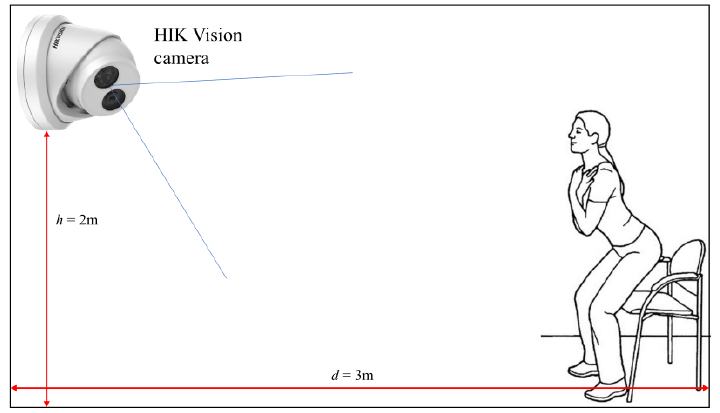
Figure 2. System setup: the HIK Vision camera is placed in front of the